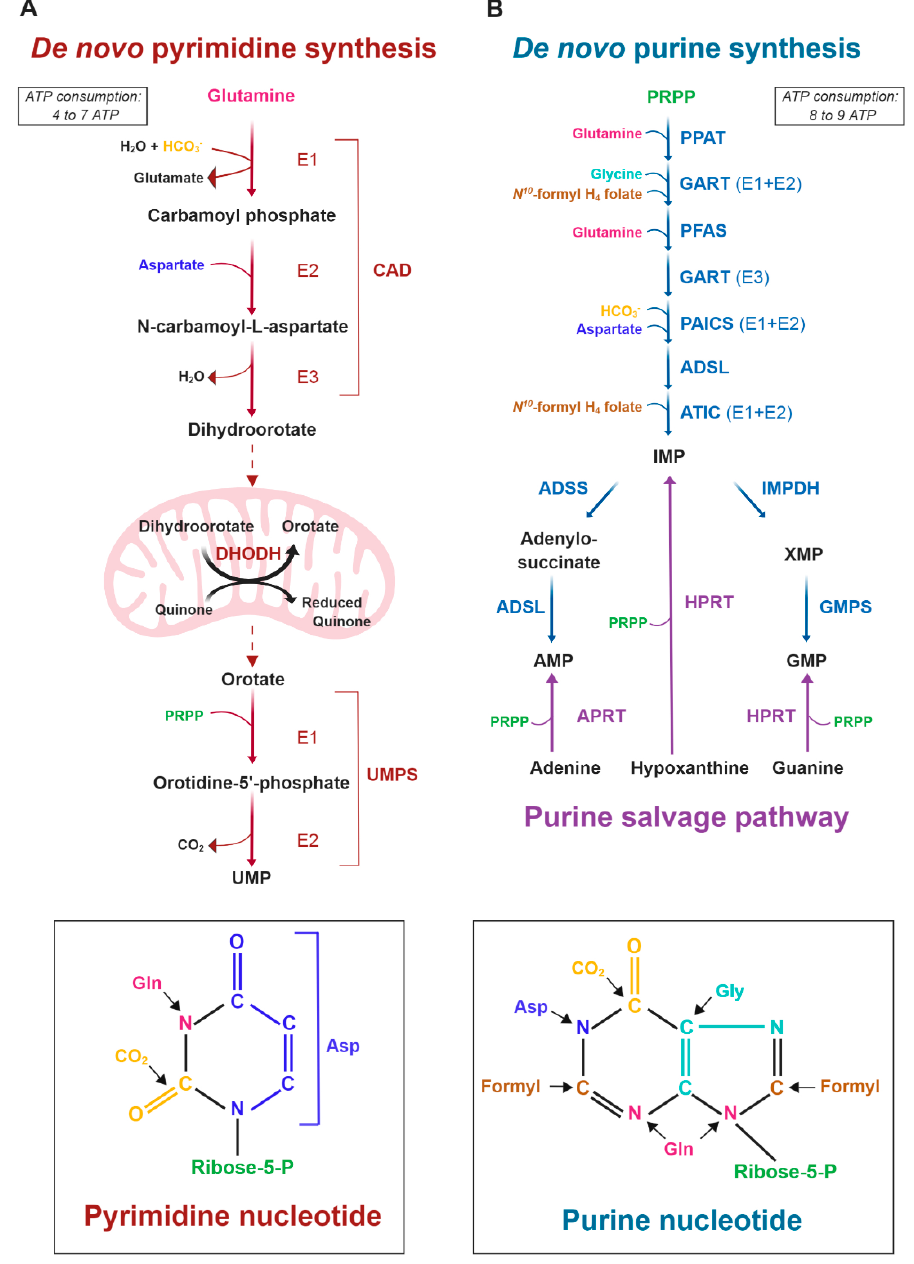
Figure 1 . The de novo pyrimidine and purine synthesis pathways. ( A ) Schematic of the de novo pyrimidine synthesis pathway. Pyrimidine synthesis enzymes: CAD: Carbamoyl-Phosphate Synthetase 2, Aspartate Transcarbamylase, And Dihydroorotase; DHODH: Dihydroorotate